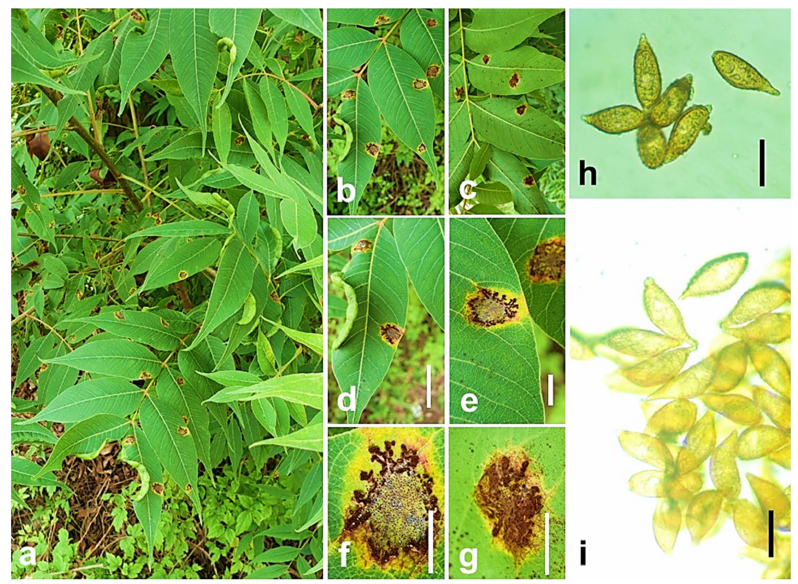
Figure 3. Skierka himalayensis . ( a – g ) Leaves of Pistacia integerrima showing rust infection (telia) on abaxial and adaxial surfaces; ( h , i ) Teliospores seen in LM. Scale bars: ( d – g ) = 1 mm; ( h , i ) = 10 µ m.